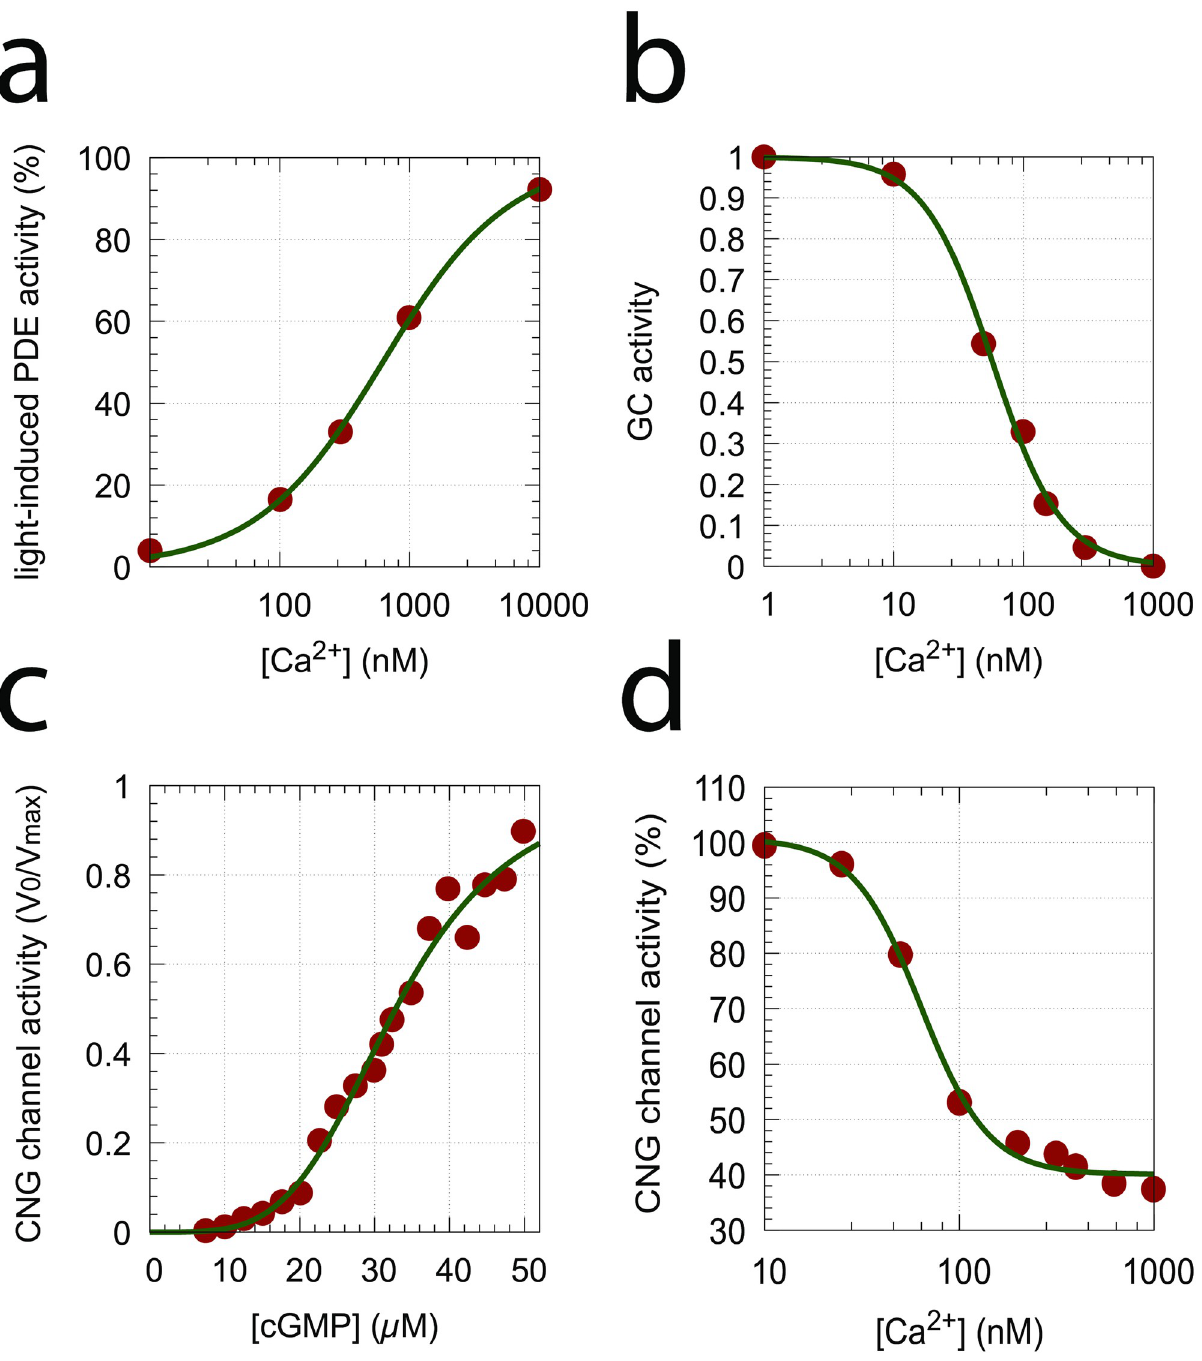
Fig 14. Normalized experimental data used to extract parameter values. (a) Light-induced PDE activity as a function of Ca 2+ concentration [40, 41]; (b) Inhibition of GC activity by Ca 2+ [42]; (c) CNG channel activity as a function of cGMP concentration [39]; (d) CNG channel activity as a function of Ca 2+ concentration